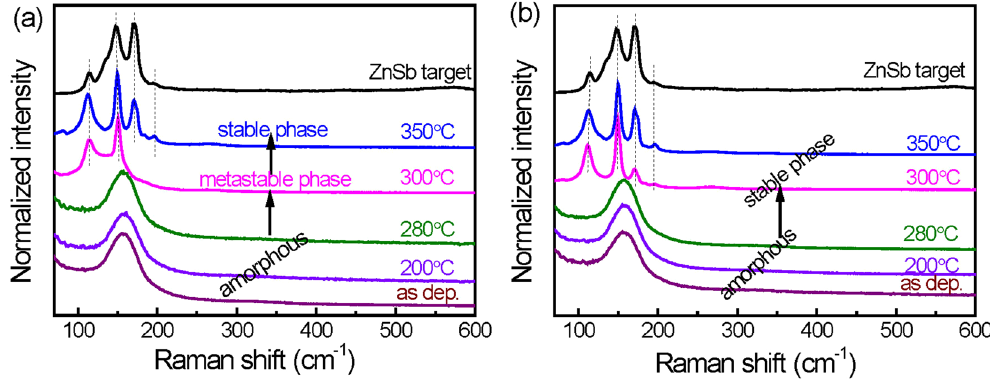
Figure 3. Raman spectra of as-deposited and annealed ( a ) undoped and ( b ) NiO-doped ZnSb films.